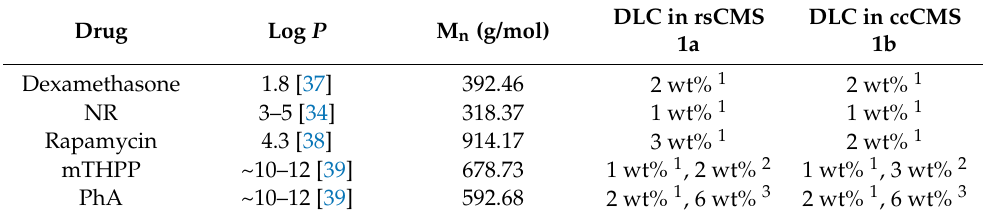
Table 3. Drug loading content (DLC) of rapamycin, mTHPP and Pheophorbide A (PhA) by rsCMS 1a and ccCMS 1b